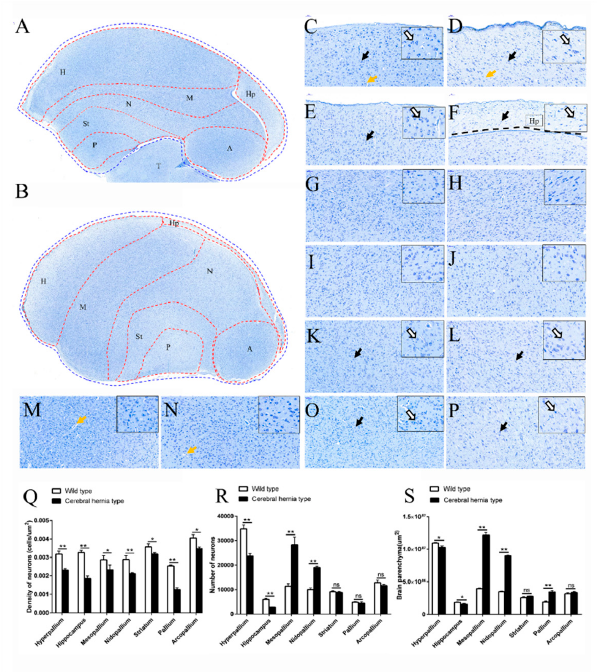
Figure 2. Comparison of the telencephalon in cerebral hernia type and wild type chickens using Nissl stain. ( A , B ) The telencephalon encircled by the blue dotted line is divided into seven regions by marking the boundaries for each region with a red dotted line in wild type chickens ( A ) and cerebral hernia type chickens ( B ). Scale bars = 500 μ m. ( C , D ) The sagittal sections of telencephalon in H region are presented in wild type chickens ( C ) and cerebral hernia type chickens ( D ). ( E , F ) The sagittal sections of telencephalon in Hp region are presented in wild type chickens ( E ) and cerebral hernia type chickens ( F ). ( G , H ) The sagittal sections of telencephalon in M region are presented in wild type chickens ( G ) and cerebral hernia type chickens ( H ). ( I , J ) The sagittal sections of telencephalon in N region are presented in wild type chickens ( I ) and cerebral hernia type chickens ( J ). ( K , L ) The sagittal sections of telencephalon in St region are presented in wild type chickens ( K ) and cerebral hernia type chickens ( L ). ( M , N ) The sagittal sections of telencephalon in A region are presented in wild type chickens ( M ) and cerebral hernia type chickens ( N ). ( O , P ) The sagittal sections of telencephalon in P region are presented in wild type chickens ( O ) and cerebral hernia type chickens ( P ). The neurons are marked with black arrows and open arrows indicating lower and higher magnification, respectively in ( C – P ). The blood vessels are indicated with yellow arrows in ( C – P ). The Hp region in cerebral hernia type chickens is located above the black dotted line ( F ). Scale bars = 50 μ m. ( Q ) Quantitative analysis of the density of neurons in the telencephalon showed the decreased tendency in all seven regions in cerebral hernia type chickens. ( R ) The number of neurons in the telencephalon is increased in M and N, but decreased in H and Hp. ( S ) Quantitative analysis of the brain parenchyma areas demonstrating enlargement of M, N, and P regions, and reduced size of H and Hp regions in cerebral hernia vs. wild type chickens. H, hyperpallium; Hp, hippocampus; M, mesopallium; N, nidopallium; St, striatum; A, arcopallium; P, pallium. Data are presented as mean SEM (from three independent samples per group). ( n = 3); * p < 0.05, ** p < 0.01 (Student’s t